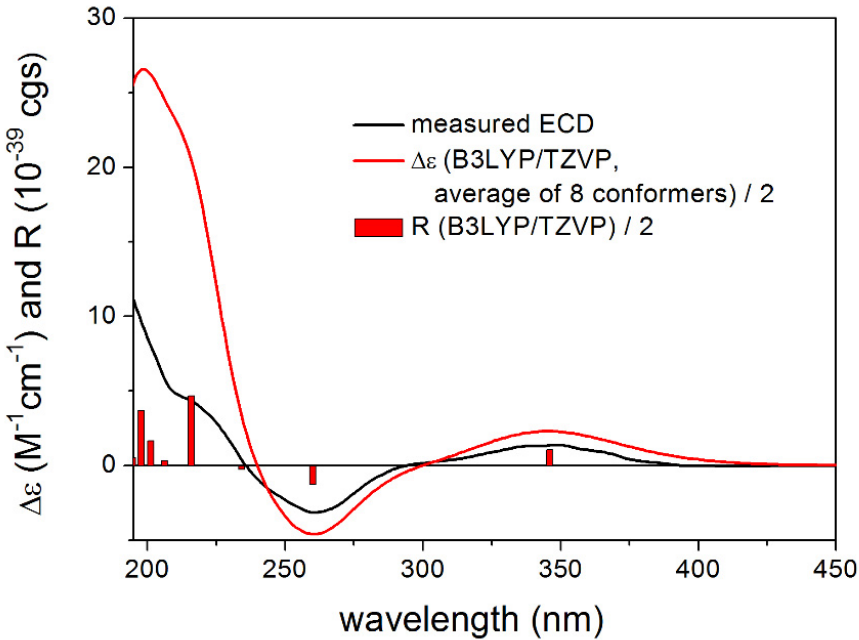
Figure 6. Experimental ECD spectrum of 4 in MeOH compared with the Boltzmann-weighted B3LYP/TZVP PCM/MeOH ECD spectrum of proposed (1 R ,2 S ,8 S )- 4 computed for the CAM-